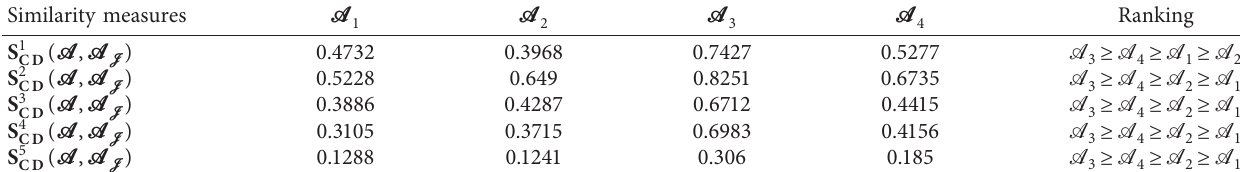
, ϕ ) � ( 0 . 5 , 0 . 5 ) . cc cc